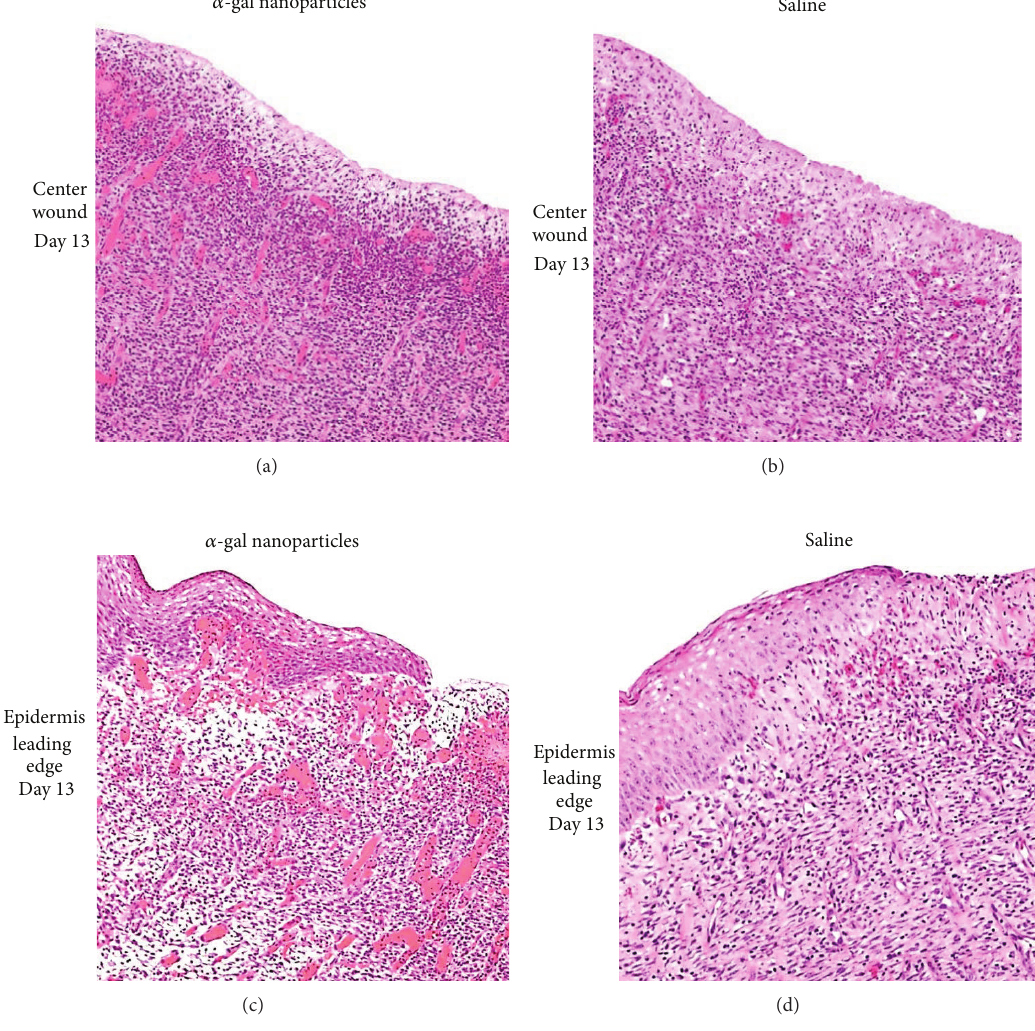
Figure 4: Vascularization of GT-KO pig wounds treated with 𝛼 -gal nanoparticles (100mg) or with saline and studied on day 13. The presented histology is of the centers of wound (not covered by regenerating epidermis), or wound areas under the leading edge of regenerating epidermis treated with 𝛼 -gal nanoparticles (a and c, resp.) or with saline (b and d, resp.). There are many more macrophages and blood vessels (filled with red stained RBC) in wound treated with 𝛼 -gal nanoparticles than in those treated with saline. Representative wounds from 6 GT-KO pigs (H&E × 200). Modified from